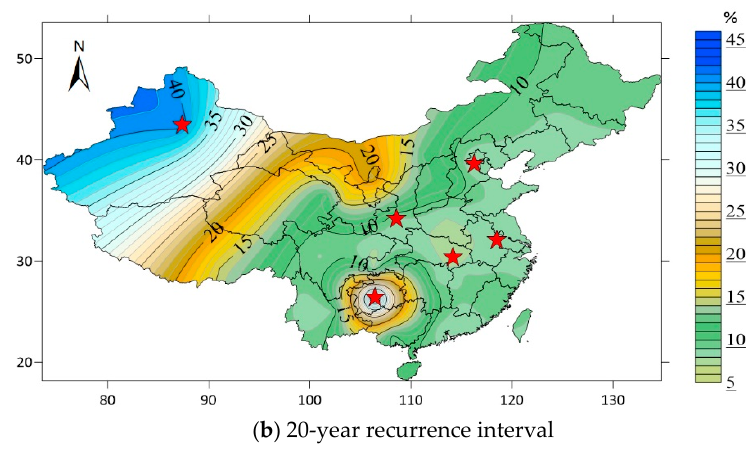
Figure 6. Relative difference in overflow volumes using IDF method for different cities in continental China under ( a ) 5-year storm and ( b ) 20-year storm. (DA/SA = 20:1, design depth = 25 cm and infiltration rate = 1.5 m/d based on 2-year design storm) ( ★ marks locations of demo cities: (from west to east) Urumqi, Guiyang, Xi’an, Wuhan, Beijing, and Nanjing).